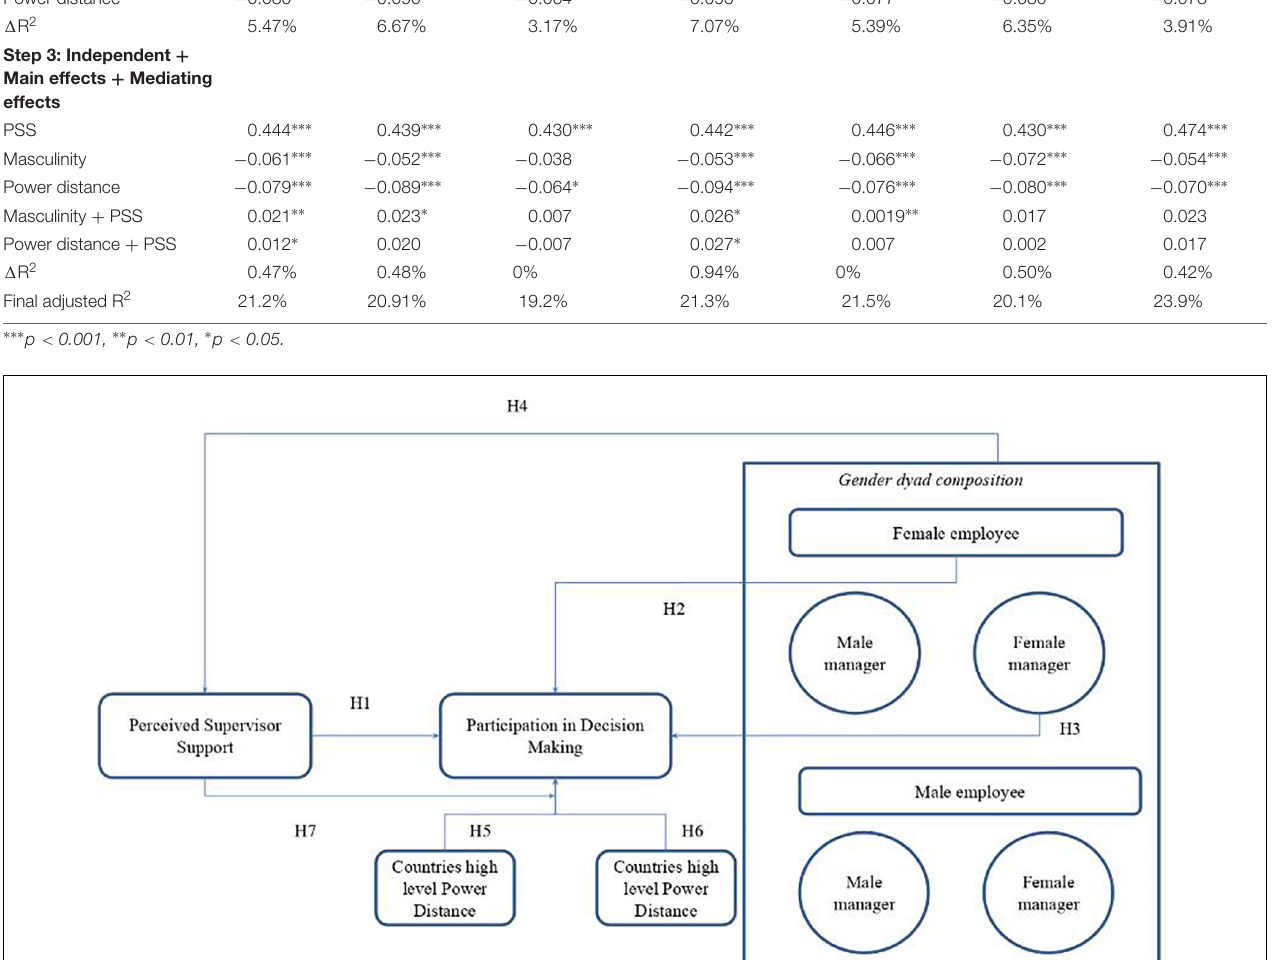
managers, respectively (without distinguishing the gender of the employees). Models 3 and 4 are related to the female manager sample, but separated by the gender of the employees. The same occurs with models 6 and 7, but in this case for the sample of male